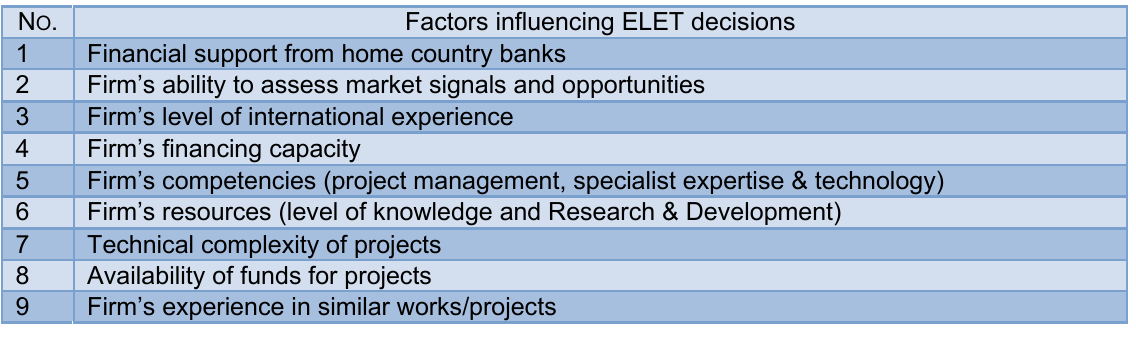
Table 13: Mutually inclusive significant factors influencing ELET decisions of firms in international market expansion